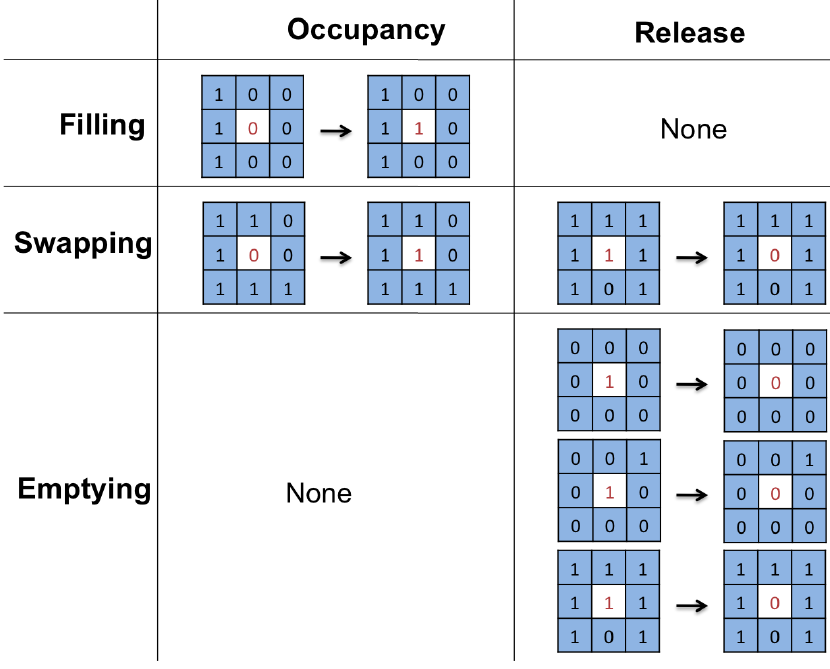
Figure 6. Rules defining occupancy and release for each